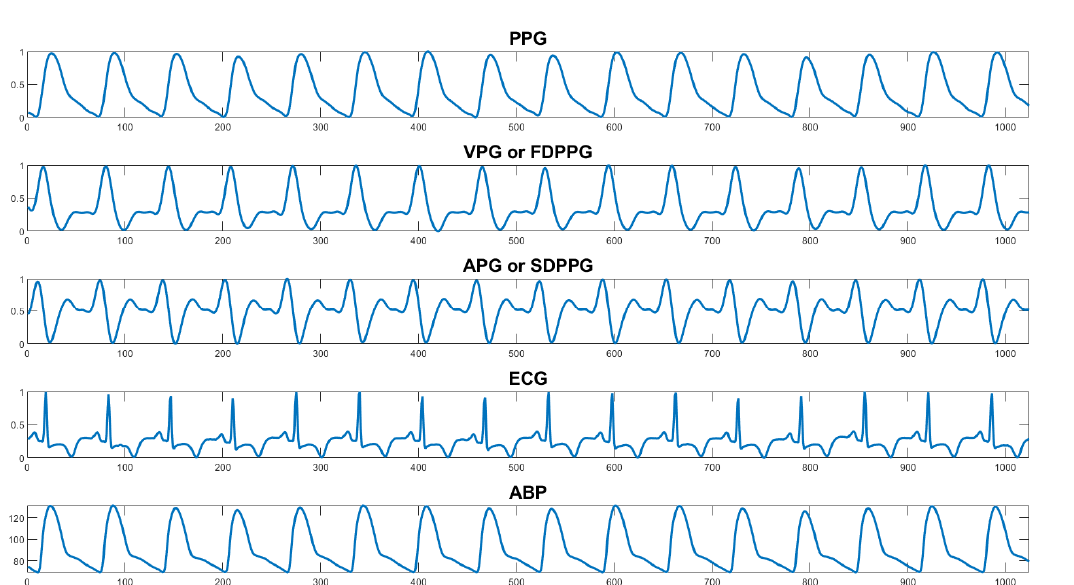
Figure 2. Snapshot of five signals (photoplethysmography (PPG), velocity of PPG (VPG), acceleration of PPG (APG), electrocardiogram (ECG), and arterial blood pressure (ABP)) from a segment of the UCI dataset after pre-processing.